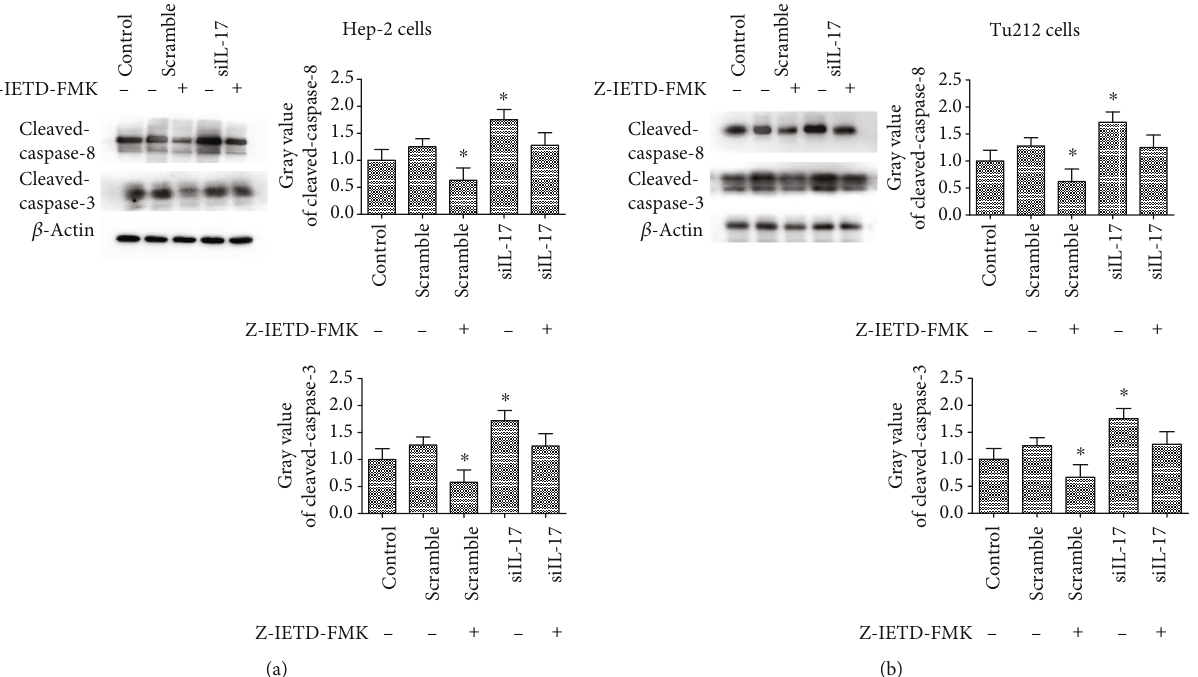
Figure 5: IL-17 inhibited apoptosis through the FAS/FASL pathway in LC cells. (a) The expression levels of cleavage of caspase-8 and cleavage of caspase-3 were examined by Western blotting in Hep-2 cells pretreated with siRNA-IL-17 for 24 h. Following culture for 24h with or without (40 μ M) Z-IETD-FMK for 0.5h. (b) The expression levels of cleavage of caspase-8 and cleavage of caspase-3 were examined by Western blotting in Tu212 cells pretreated with siRNA-IL-17 for 24h. Following culture for 24 h with or without (40 μ M) Z- IETD-FMK for 0.5h. All assays were performed in triplicate ( ∗ P < 0 : 01 versus the